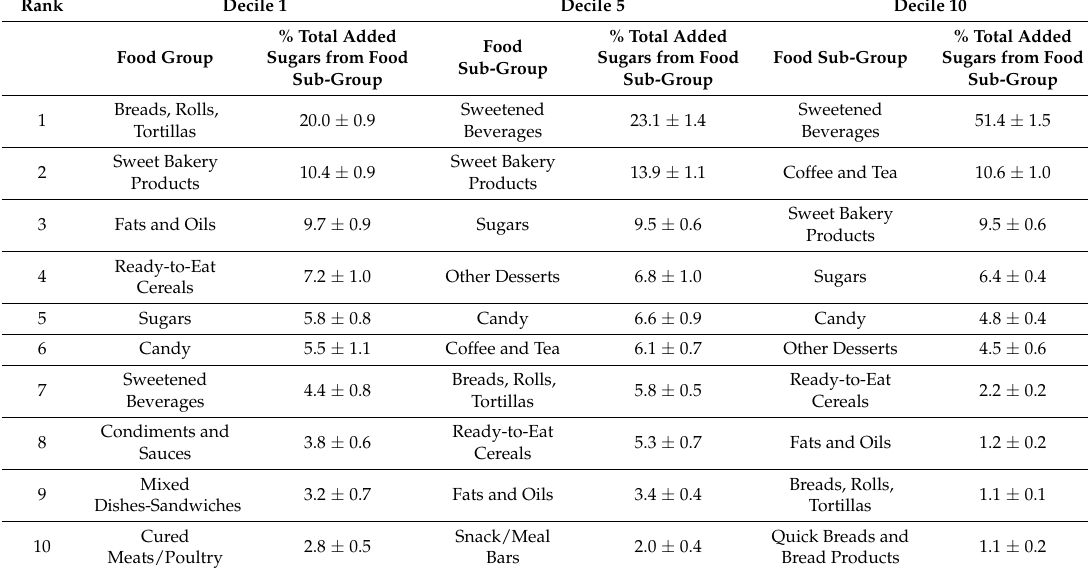
Table 5. Top ten food sources of added sugars for adults ≥ 19 years by decile of intake, data from the National Health and Nutrition Survey, 2009–2012 ( n = 10,697) 1